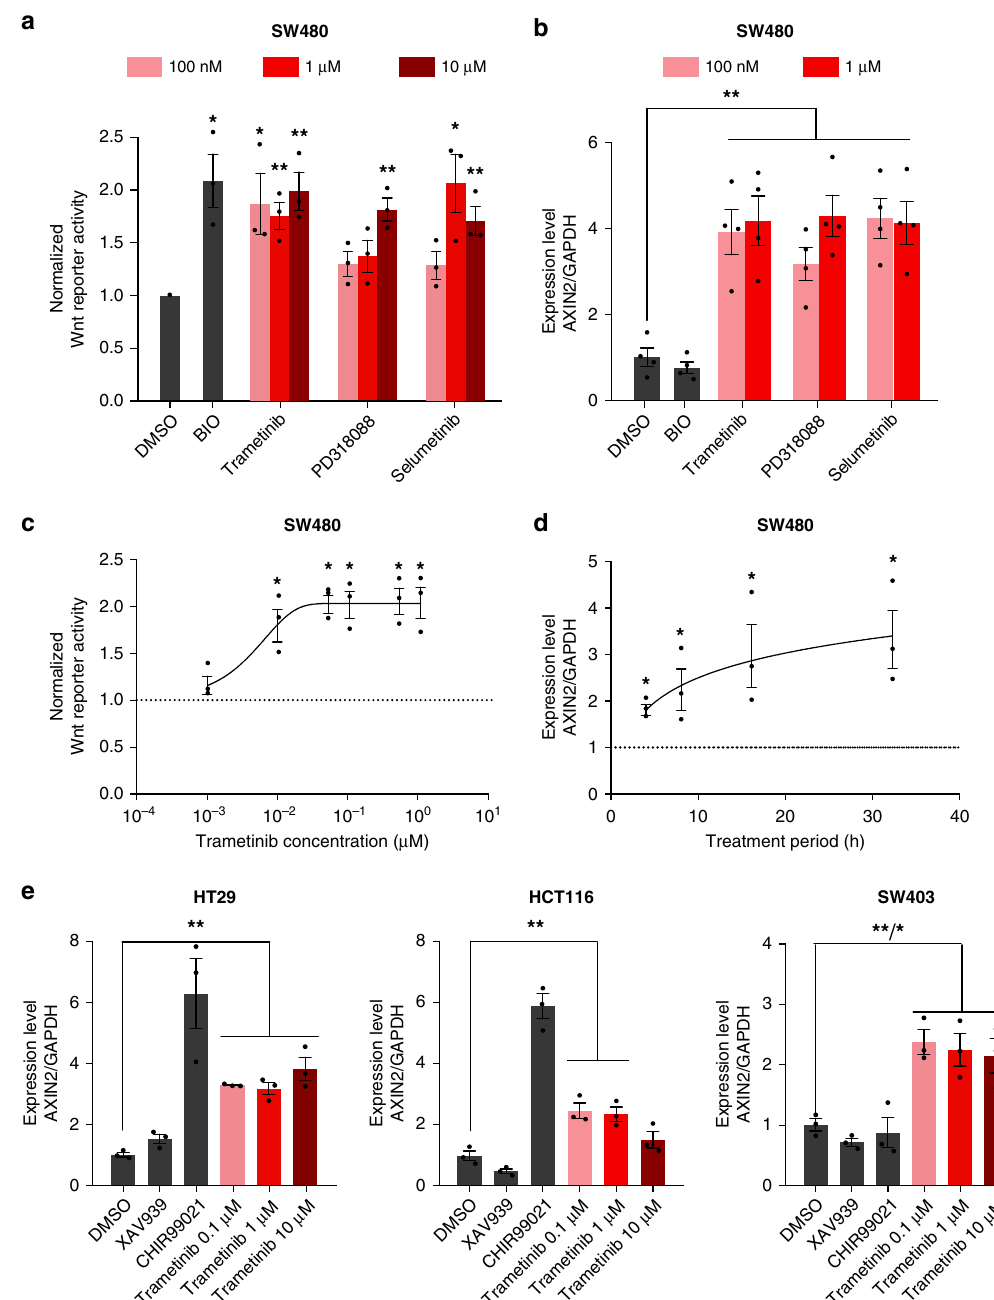
Fig. 2 Characteristics of Wnt activation by MEK inhibitors. a – b Wnt reporter activity and target gene expression are increased by MEK inhibitors. SW480 – 7TFP were treated with different concentrations of the MEK inhibitors selumetinib, PD318088 or trametinib. TCF/Wnt-luciferase and CellTiterGlo signals were determined and normalised to DMSO controls ( a ) and expression of AXIN2 was measured by qPCR ( b ). c Concentration dependent activation of Wnt signalling by MEK inhibitor trametinib. SW480 – 7TFP cells were treated with different concentrations of trametinib for 24 h. TCF/Wnt reporter activity and CellTiterGlo signal were determined and normalised to DMSO controls. d Time-dependent activation of Wnt signalling by trametinib. SW480 cells were treated for different time periods with 1 µ M of trametinib and expression of Wnt target gene AXIN2 was measured by qPCR. e Trametinib activates Wnt signalling in different colorectal cancer cell lines. HT29, HCT116 and SW403 cells were treated with indicated concentrations of trametinib for 24 h and AXIN2 transcript levels were determined by qPCR. The tankyrase inhibitor XAV939 serves as negative and the GSK3 inhibitor CHIR99021 as positive control. a – e Data from three independent experiments are presented as mean ± s.e.m. * p < 0.05, ** p < 0.01, two-sided Student ’ s t